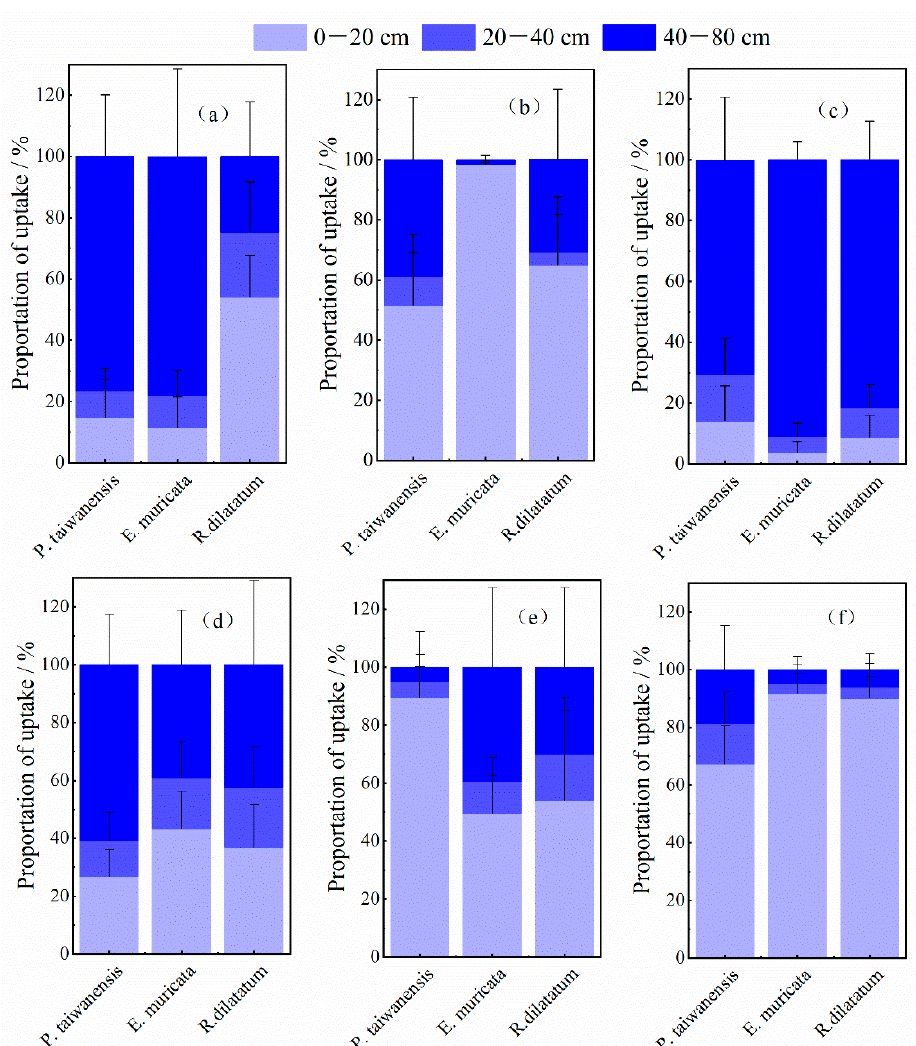
Figure 7. Seasonal variations in proportion of water uptake from different soil layers based on MixSIAR of P. taiwanensis , E. muricata and R. dilatatum . Error bars represent standard deviations (N = 3). “( a – f )” represent the chronological months from July to January of the following year.